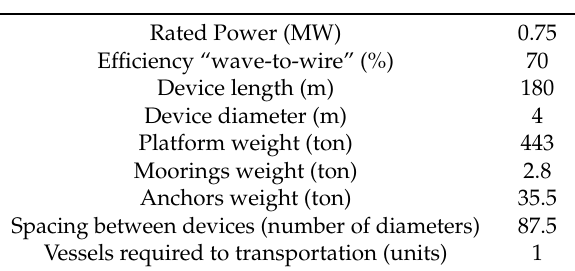
Figure 5. Illustration of the ( a ) small and ( b ) big wave farms of Case 1. Table 5. Pelamis characteristics.